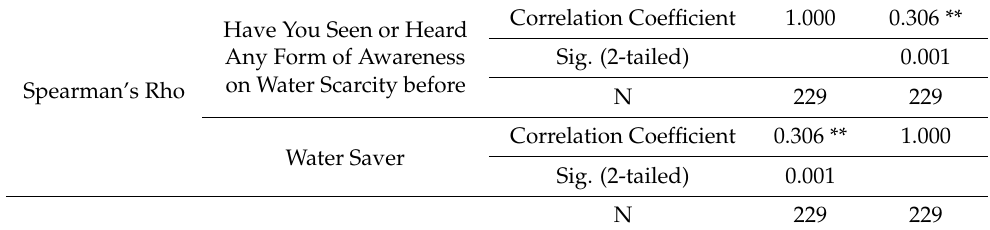
Table 4. Spearman’s rho correlations between advertisements and water scarcity and water savers. Correlation Coefficient 1.000 0.306 ** Have You Seen or Heard Any Form of Awareness Sig. (2-tailed) 0.001 on Water Scarcity before Spearman’s Rho N 229 229 Correlation Coefficient 0.306 ** 1.000 Water Saver Sig. (2-tailed) 0.001 N 229